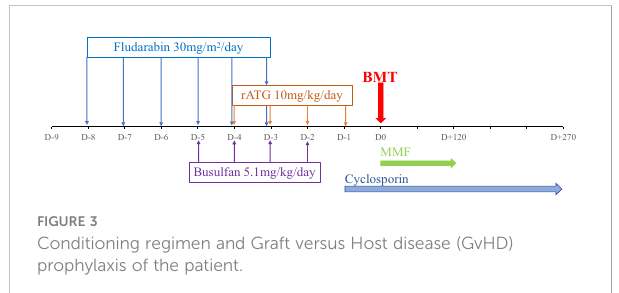
FIGURE 3 Conditioning regimen and Graft versus Host disease (GvHD) prophylaxis of the patient.